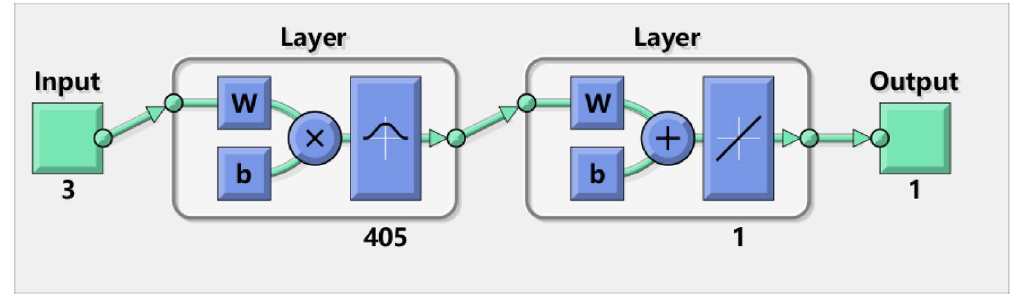
Figure 2. Typical RBF